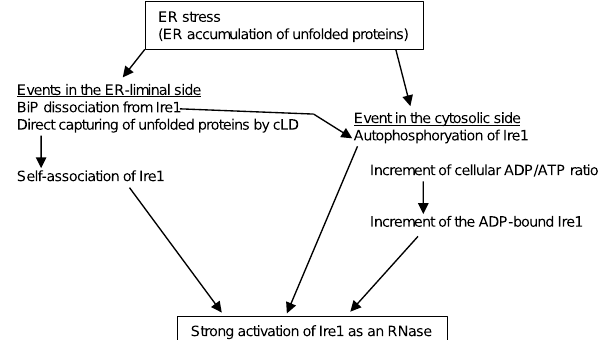
Figure 8. Our model for activation of Ire1 in response to ER stress. On the ER-luminal side, unfolded proteins cause dissociation of BiP from Ire1. Moreover, Ire1 directly captures unfolded proteins. These events cause self-association of Ire1. On the cytosolic side, BiP-unbound and dimerized Ire1 molecules are automatically autophosphorylated. Moreover, potent ER stress increases the cellular ADP/ATP ratio. This also contributes to the activation of Ire1, because ADP serves as an activation ligand of